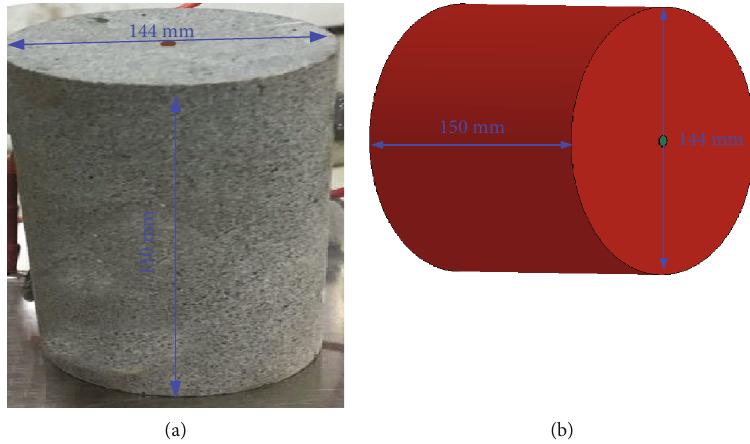
Figure 4: Illustration of laboratory and numerical setup: (a) laboratory setup; (b) numerical setup. Table 2: Parameters for the RHT model for rock.